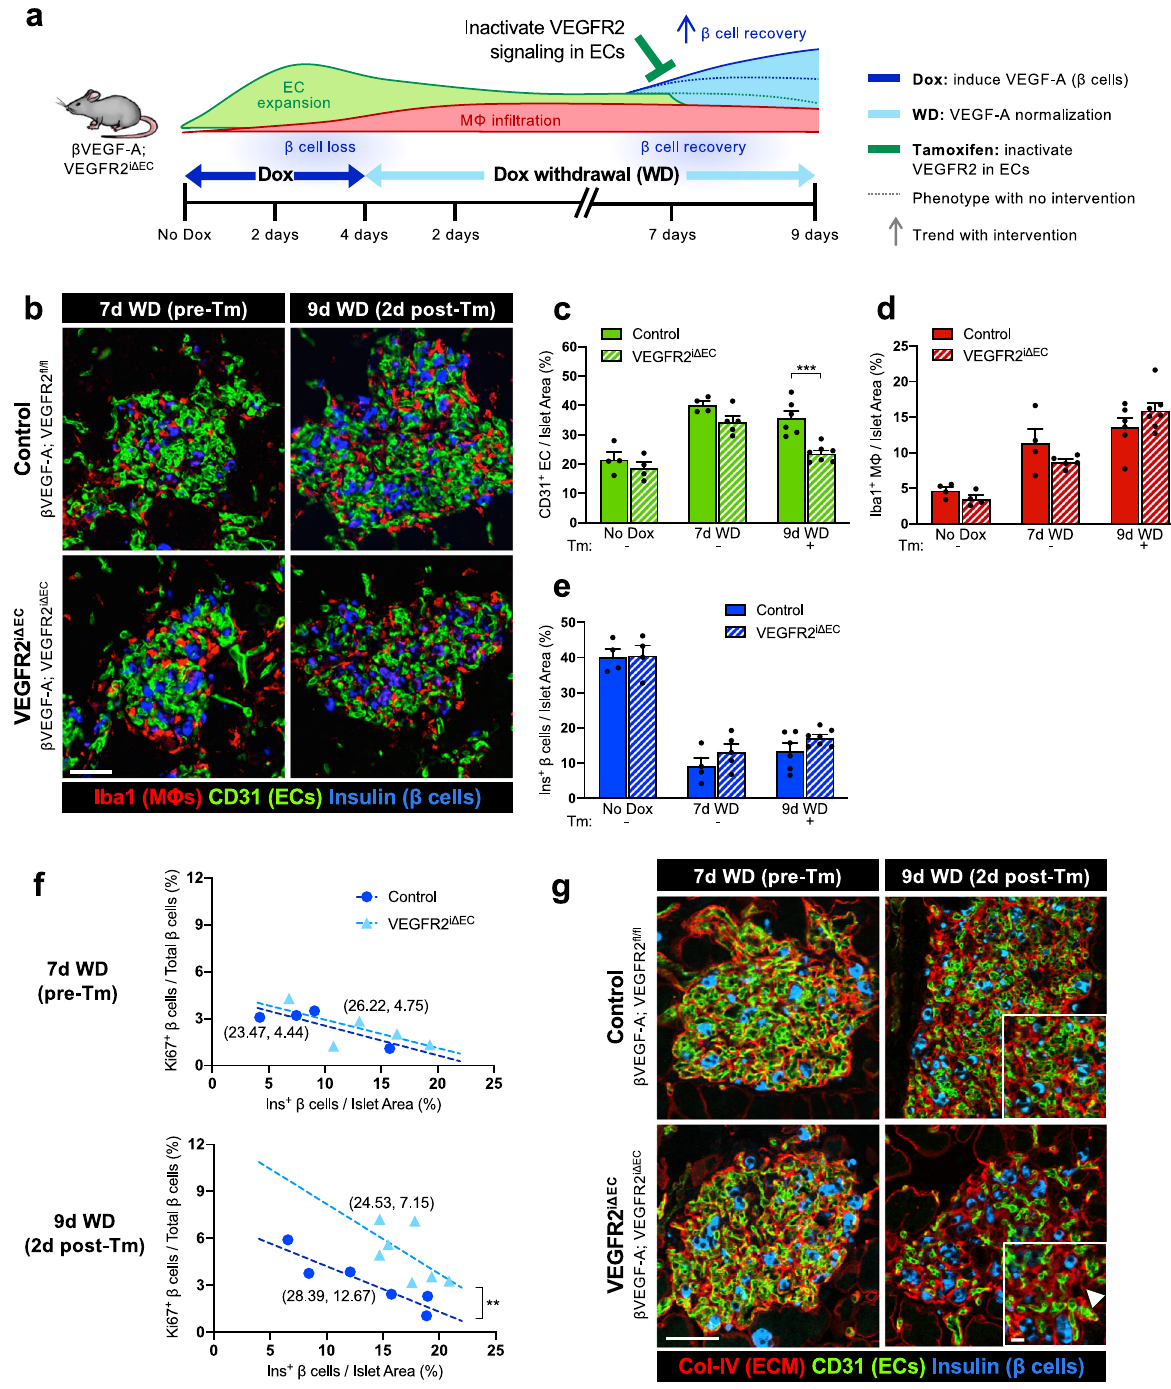
Fig. 4 Phenotypic and structural changes to the islet microenvironment in response to VEGFR2 inactivation in quiescent endothelial cells during β cell recovery. a To inactivate VEGFR2 in endothelial cells (ECs) during β cell recovery, control ( β VEGF-A; VEGFR2 f/ fl ) and VEGFR2 i Δ EC ( β VEGF-A; VEGFR2 i Δ EC ) mice received Tamoxifen (Tm; 4 mg s.c.) after 7 days (d) of Dox withdrawal (WD). b Islet architecture visualized by labeling for macrophages (Iba1 + ) ECs (CD31 + , green), β cells (Insulin + , blue) at 7d WD (pre-Tm) and 9d WD (2d post-Tm). Scale bar, 50 μ m. c – e Area quanti fi cation (mean + s.e.m.) of islet ECs ( c ), M Φ s ( d ), and β cells ( e ) by immunohistochemistry; 14 ± 1 × 10 5 μ m 2 total islet area analyzed per animal. Each circle represents one animal; asterisks indicate results of unpaired two-tailed t -tests between genotypes; *** p < 0.001. f β cell proliferation rates (1,947 ± 145 β cells per animal) plotted as a function of β cell loss (% β cells of total islet area) reveal a signi fi cant increase after VEGFR2 inactivation in quiescent ECs at 9d WD. Parentheses beside lines provide x - and y -intercepts derived from linear regression. At 9d WD, intercepts are signi fi cantly different; ** p < 0.01. g Visualization of islet extracellular matrix by immuno fl uorescence (ECM; Col-IV + , red), ECs (CD31 + , green), β cells (Insulin + , blue) at 7d WD (pre-Tm), and 9d WD (2d post-Tm). Scale bar, 50 μ m; inset, 10 μ m. Arrowhead in bottom right panel points to ECM casts where ECs have